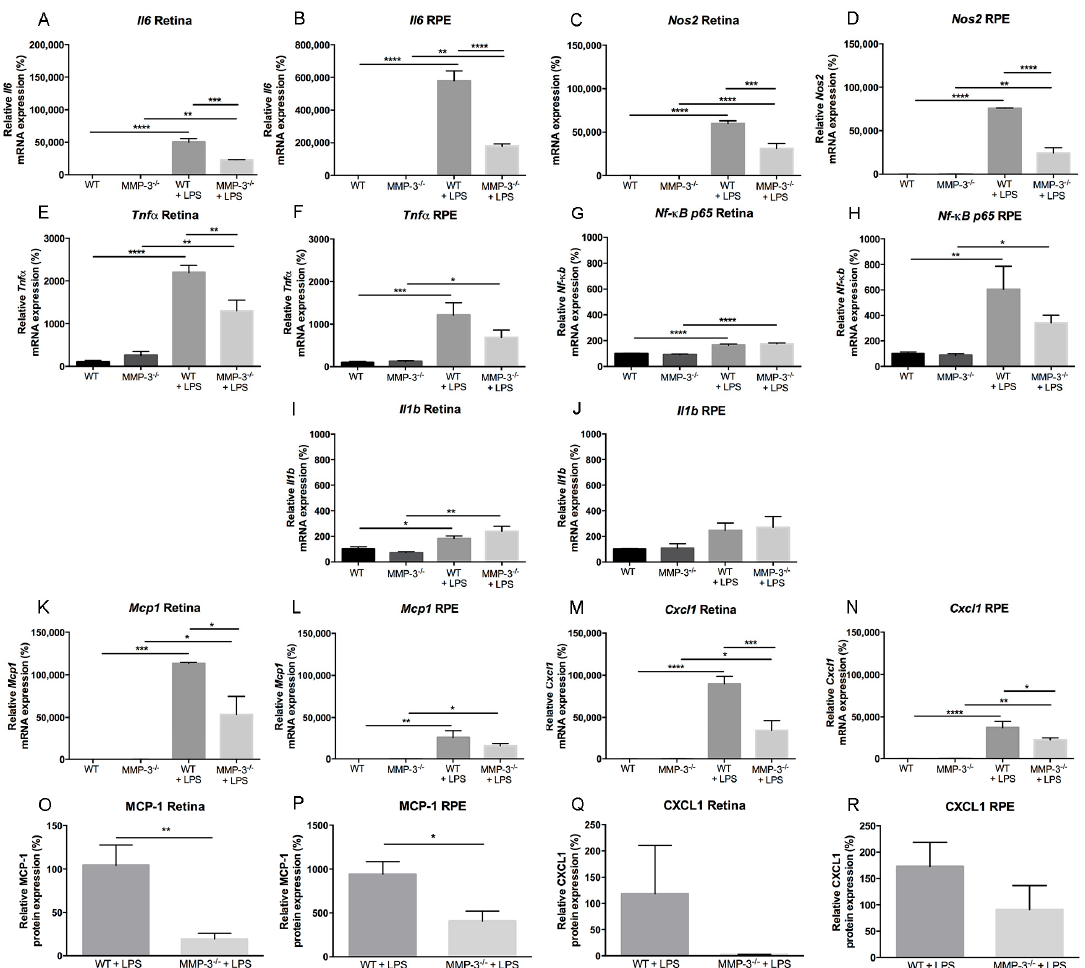
Figure 5. MMP-3 deficiency prevents strong upregulation of inflammatory-associated molecules in the retina and RPE during EIU. ( A – N ) The gene expression levels of interleukin 6 ( Il6 ), nitric oxide synthase ( Nos2 ), tumor necrosis factor alpha ( Tnf α ), nuclear factor kappa B p65 subunit ( Nf- κ B p65 ), Il1b and monocyte chemoattractant protein ( Mcp1/Ccl2 ), (C-X-C motif) ligand 1 ( Cxcl1 ) were performed on WT and MMP-3 − / − retinal and RPE samples at 0 and 16 hpi. Healthy retina and RPE samples from WT and MMP-3 − / − mice showed very low to undetectable mRNA levels. Most of the inflammatory genes, i.e., Il6 ( A , B ), Nos2 ( C , D ), Tnf α ( E , F ), Mcp1 ( K , L ) and Cxcl1 ( M , N ) were significantly upregulated in WT eyes subjected to EIU (16 hpi), and to a much lesser extent, in the MMP-3 − / − retina and RPE; Nf- κ B p65 ( G , H ) is predominantly upregulated in the RPE, and MMP-3 deficiency reduces its levels in the RPE, yet not significantly; Il1b ( I , J ) showed only a limited upregulation in WT and MMP-3 − / − retinal and RPE samples subjected to EIU, and no clear difference was revealed between WT and MMP-3 − / − mice after LPS. For most of the inflammatory molecules, the highest increase in mRNA levels, as well as the most pronounced difference between the WT and MMP-3 − / − condition, is observed in the RPE. RT-PCR data were normalized against the reference genes and were expressed as a percentage relative to 0 hpi ( n ≥ 3); ( O – R ) Retinal and RPE samples from WT and MMP-3 − / − mice with or without LPS injection were also analyzed for the pro-inflammatory chemokines MCP-1 ( O , P ) and CXCL1 ( Q , R ) at the protein level via cytometric bead array at 16 hpi. Levels of both MCP-1 and CXCL1 are significantly upregulated after EIU in WT mice and MMP-3 deficiency clearly suppressed this augmentation, especially the MCP-1 protein levels. Data are shown as mean ± SEM, n ≥ 5, * p ≤ 0.05, ** p ≤ 0.01, *** p ≤ 0.001 and **** p ≤ 0.0001. Data with no indicated statistical analysis point out no significant results.